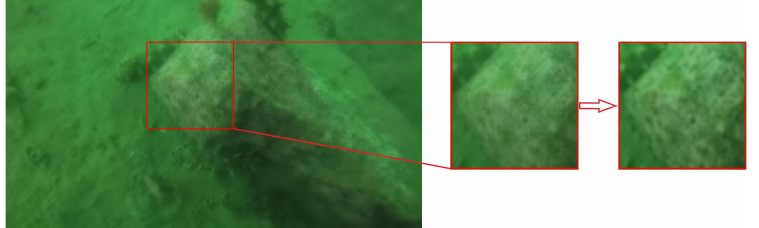
Figure 3. The fringe phenomenon caused by a sparse filter matrix. A sparse filter could only capture changes of pixels in the 8 directions; therefore starlike artifacts were found in the denoised image. The rightmost image patch shows the result of the FDI filter, and the artifacts were perfectly removed. We also made a quantitative comparison between the input image and filtered images: SSIM ( FI , input ) = 0.939 and SSIM ( FDI , input ) = 0.947. This image is from the RUIE dataset [18], and the SSIM can be calculated by Equation